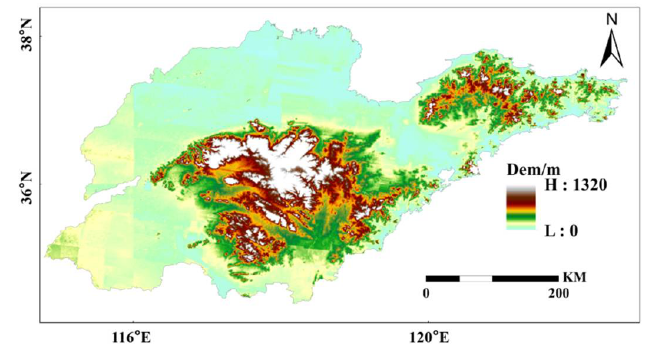
Figure 1. Location map of the study area.